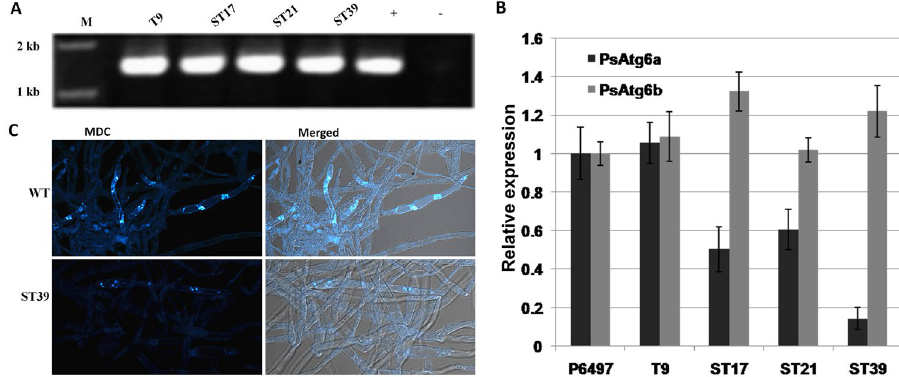
Figure 8. Construction of PsAtg6a -silenced lines. ( A ) Verification of incorporation into genomic DNA by PCR using oligonucleotides from the Ham34 promoter and terminator regions as primers. The transgene should yield an amplified fragment 1520 bp in length. + : plasmid DNA; WT: wild-type strain P6497; M: molecular markers. ( B ) qRT-PCR measurement of the relative transcript levels of PsAtg6a and PsAtg6b in control (P6497), control (T9) and silenced (ST17, ST21 and ST39) transformants. The relative expression levels were calculated using TEF1 as the reference gene. The bars indicate standard errors, and stars above the bars indicate that the difference from the wild-type value was significant. ( C ) Visualization of autophagic activation with MDC in wild type and ST39. P. sojae wild-type or ST39 hyphae were incubated in 10% V8 juice for 30 h. After 3 washes and incubation with sterile distilled water for 4 h, hyphae samples were concurrently stained with MDC and analyzed by confocal microscopy. Bars = 10 μ m.